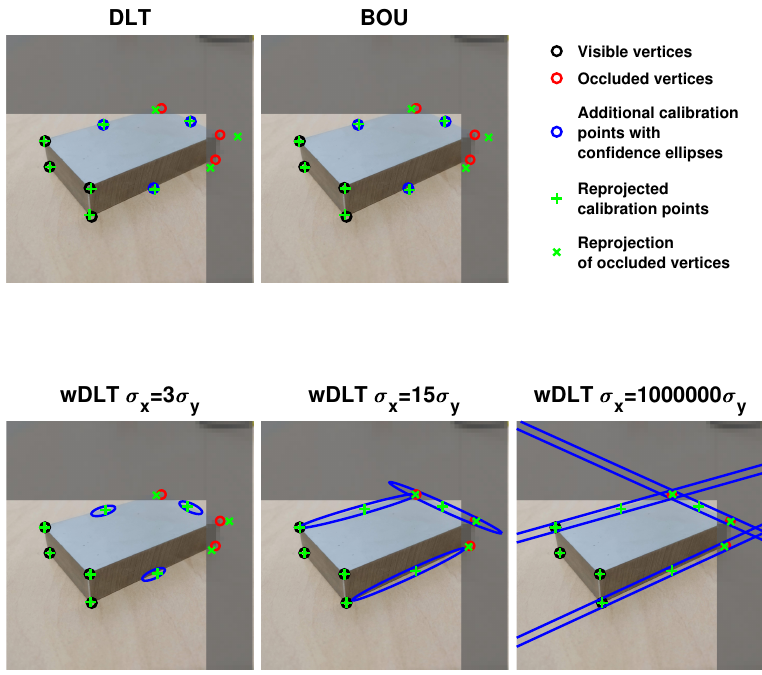
Figure 4. Scenario 2 with three occluded points and m = 0.50: black circles are the visible vertices, the red ones the occluded vertices (not used in calibration), and the blue ellipses the confidence ellipses of the additional control points on the edges. We represent each ellipse 50 times bigger in order to make them clearly visible. The green pluses and the green crosses are respectively the reprojected control points and the reprojected occluded vertices. While DLT and BOU reach good alignment of the control points (black and blue circles), the reprojection error on the occluded vertices is high. Instead, wDLT reaches a better calibration because the error on the occluded vertices’ reprojection is